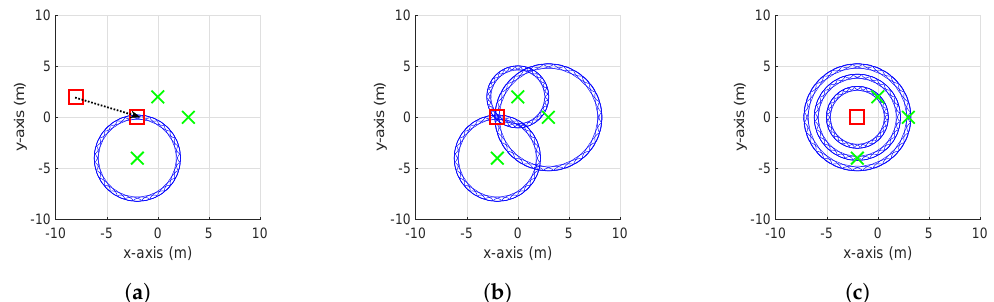
Figure 2. Description of the updated procedures for tracking moving nodes. ( a ) Reset the SoG variables from the neighbor node to the moving node, ( b ) update and merge the SoG variables, and ( c ) reset the SoG variables from the moving node to its neighbor nodes and update the corresponding weights. The red squares and green crosses represent the moving nodes and neighbor nodes, respectively. The black dotted line represents the movement of a